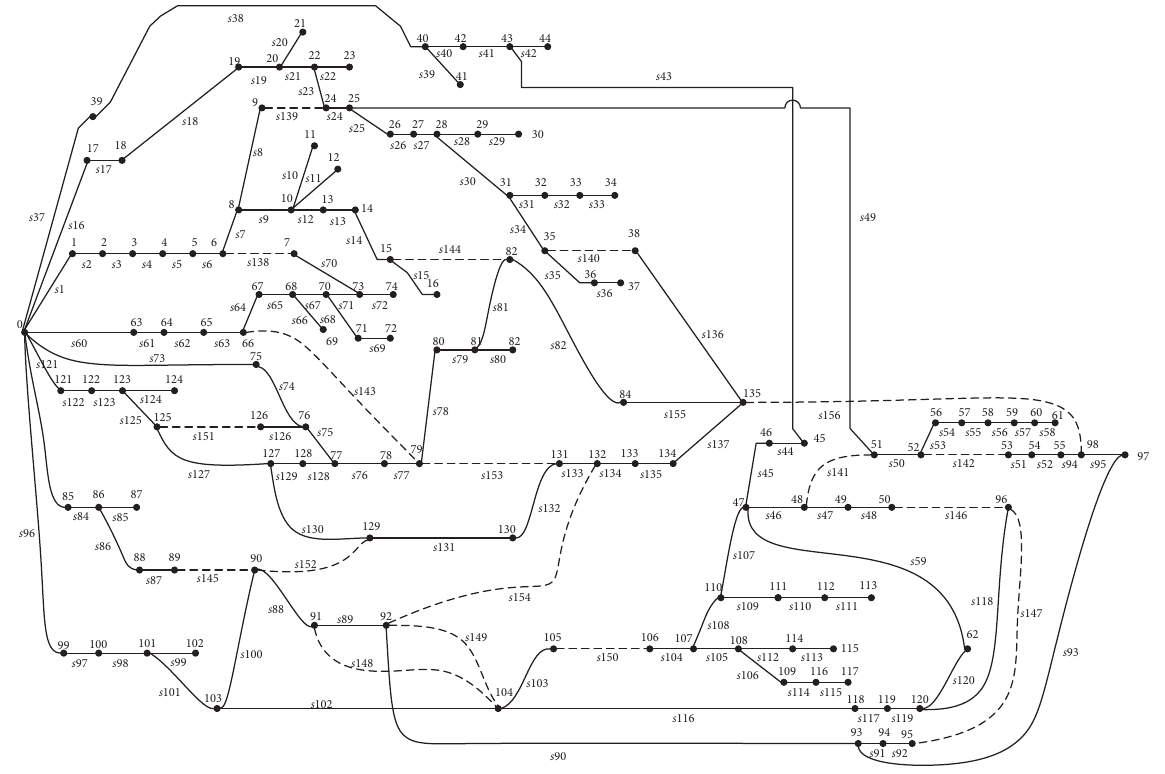
Figure 13: Single-line diagram of the 136-bus test system. Table 5: Result comparison of the proposed CSFSA with other methods for the 136-bus system. Power loss Method Tie-switches